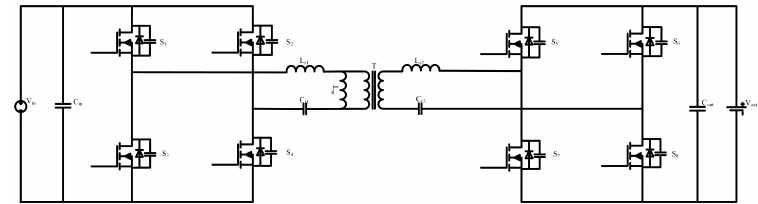
Figure 2. Topology of bidirectional fullbridge CLLC resonant